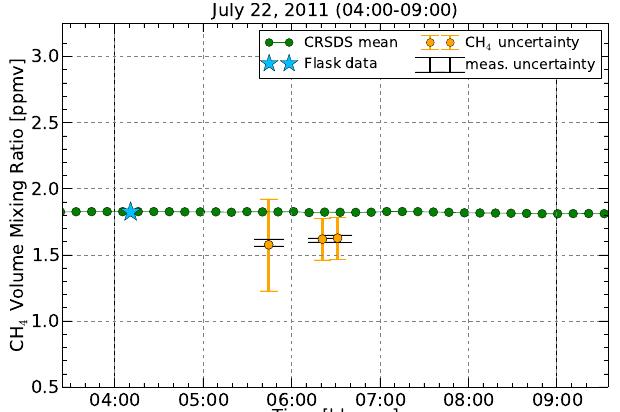
Figure 9. Retrieval results for CH 4 volume mixing ratios for the three ∼ 10min periods of available data from the short campaign period allocated to CH 4 in the morning of 22 July 2011 (within 04:00 to 09:00UTC). The layout of the panel and the data shown are the same as for the CO 2 panels in Fig. 8; see that caption for